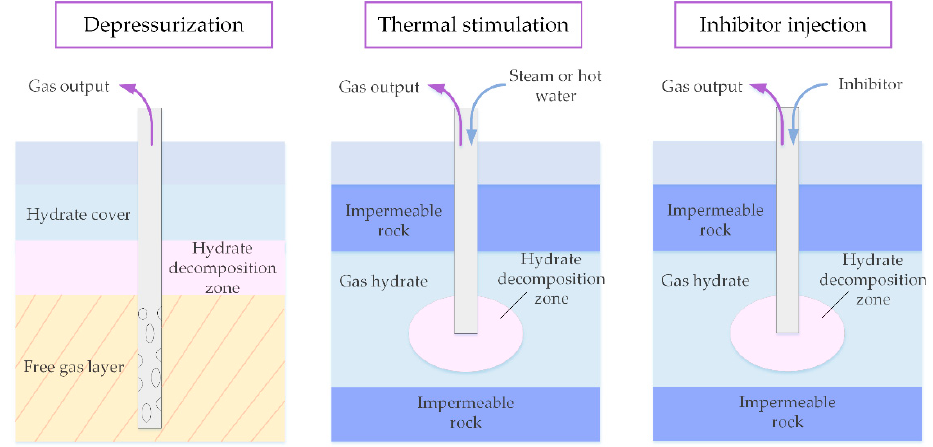
Figure 2. Main methods of gas production from gas hydrates.